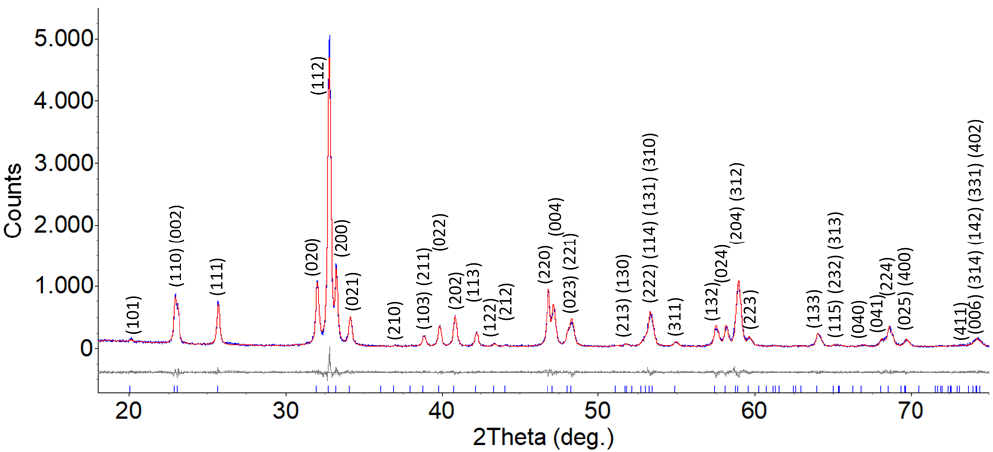
Figure 2. XRD analysis of the synthesized SmFeO 3 powder. Planes’ indices are indicated in the graph alongside relative peaks. The spectrum highlights the presence of the Pbnm space group (pdf 01-074-1474).